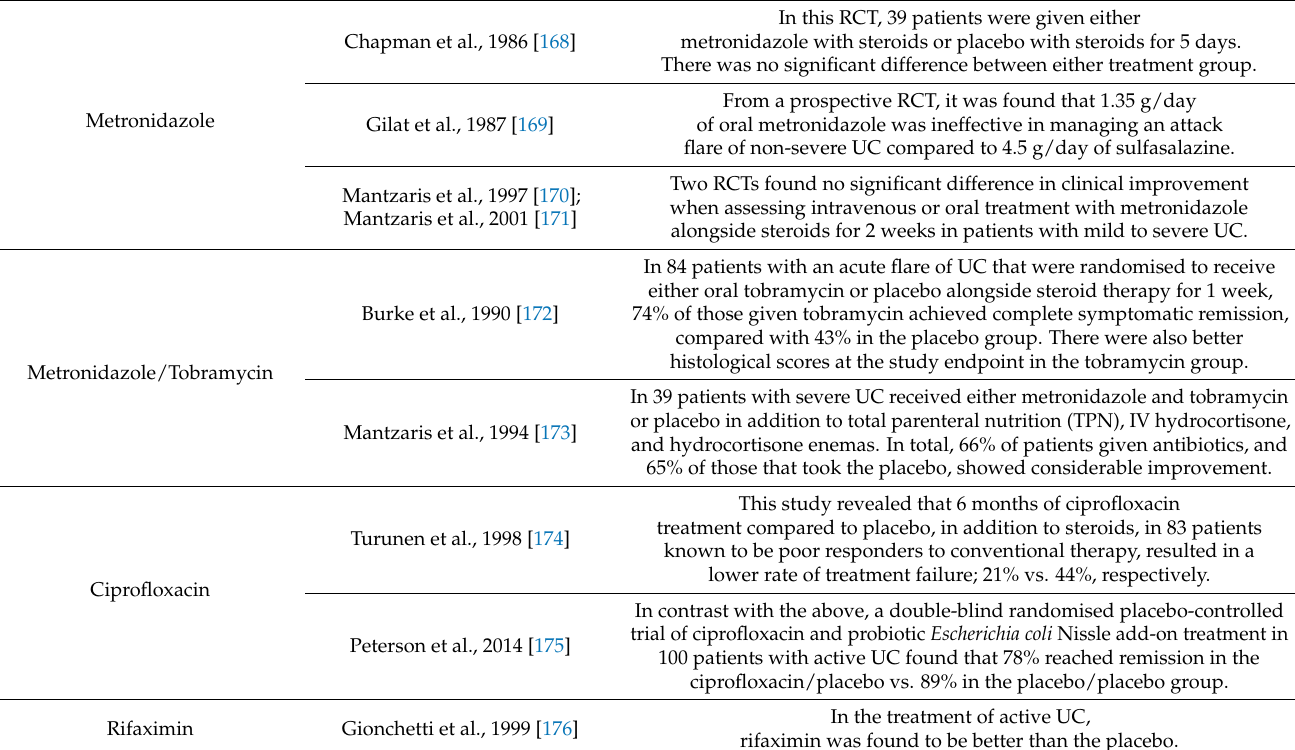
Table 8. Detailing studies assessing the efficacy of antibiotics in active ulcerative